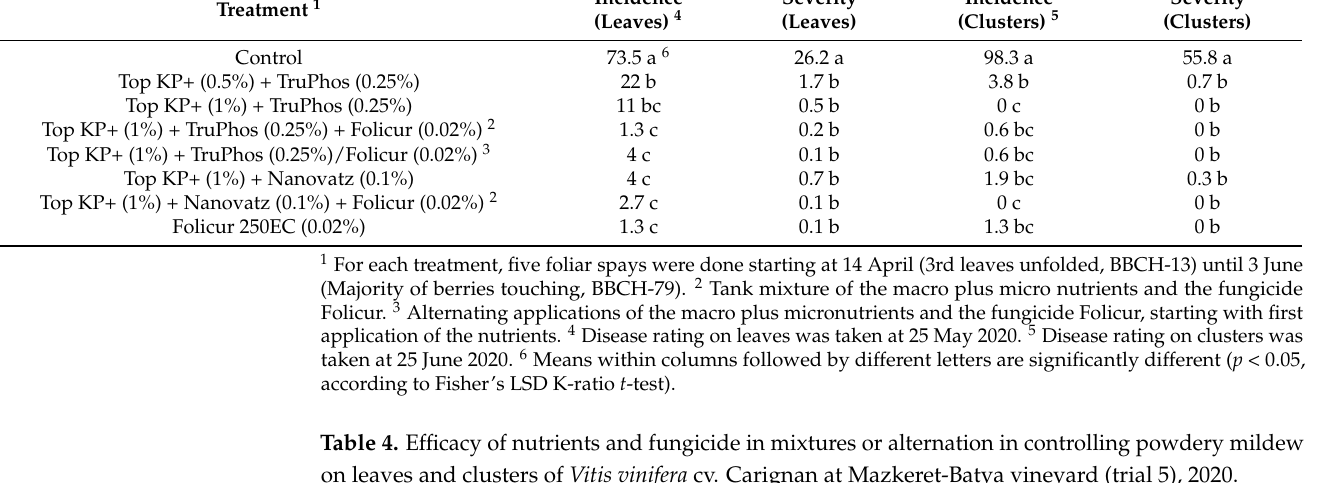
Table 3. Efficacy of nutrients and fungicide in mixtures or alternation in controlling powdery mildew on leaves and clusters of Vitis vinifera cv. Riesling at Eshtaol vineyard (trial 4), 2020. Treatment 1